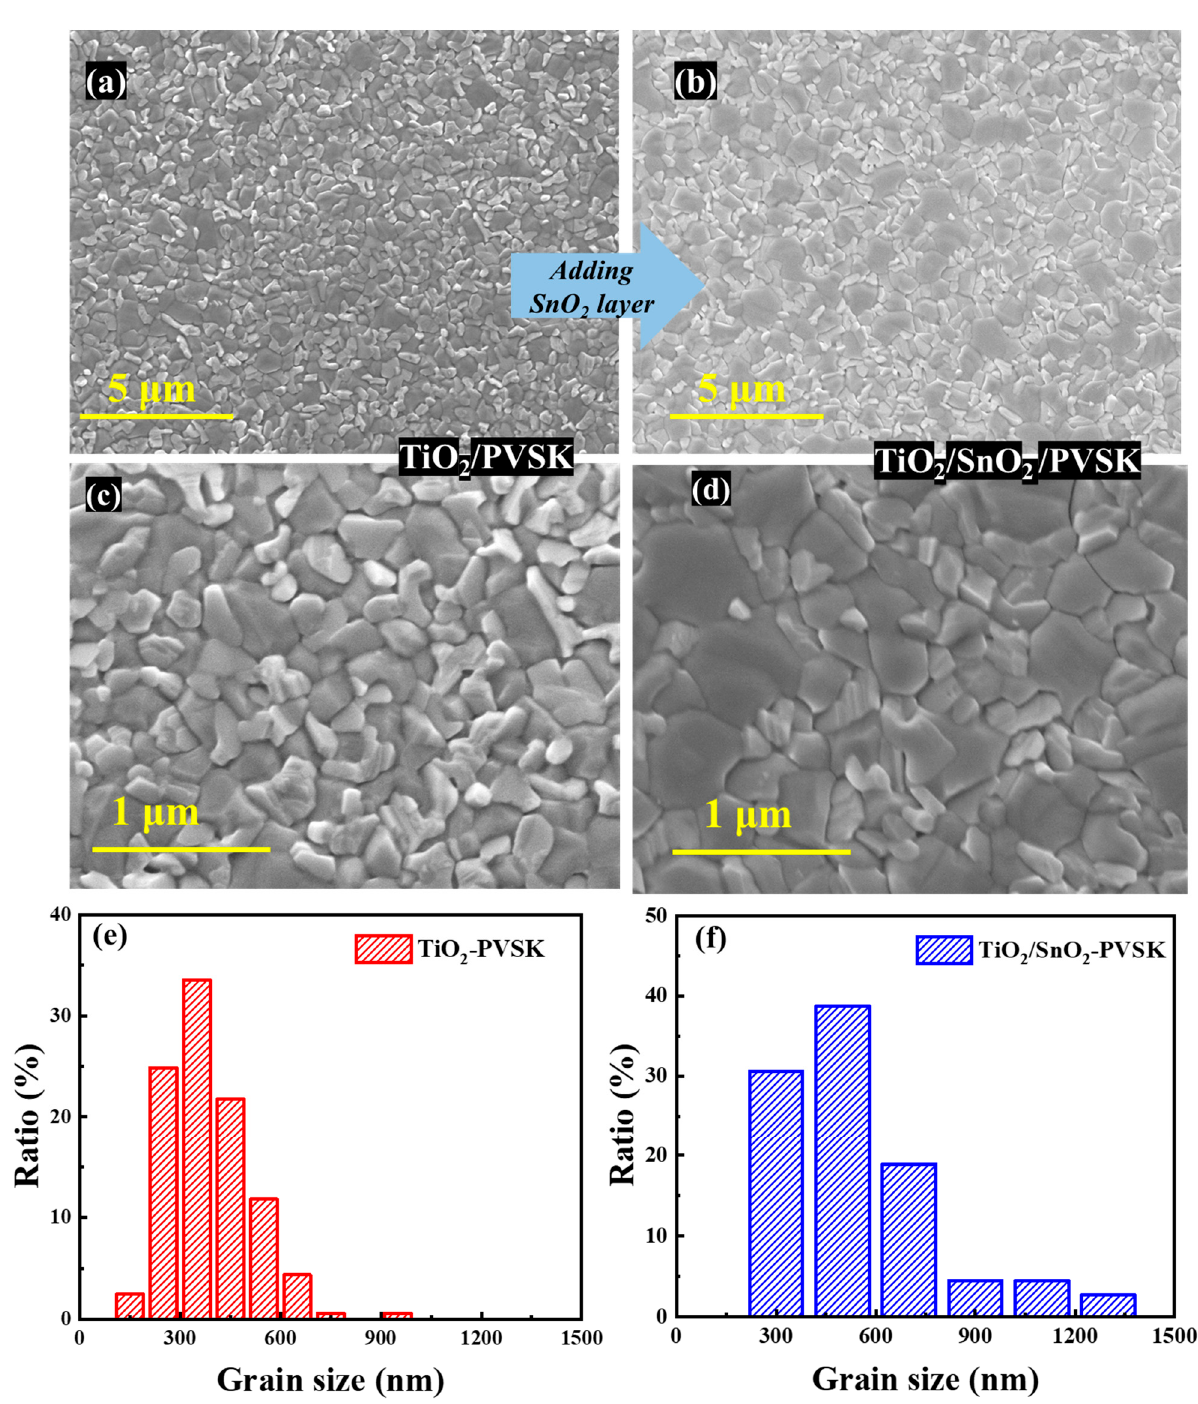
Figure 2. ( a ) Top-view SEM images of monolayer TiO 2 -ETL PSCs and bilayer TiO 2 /SnO 2 -ETL PSCs ( a – d ), and their corresponding statistic of grain size ( e , f ).